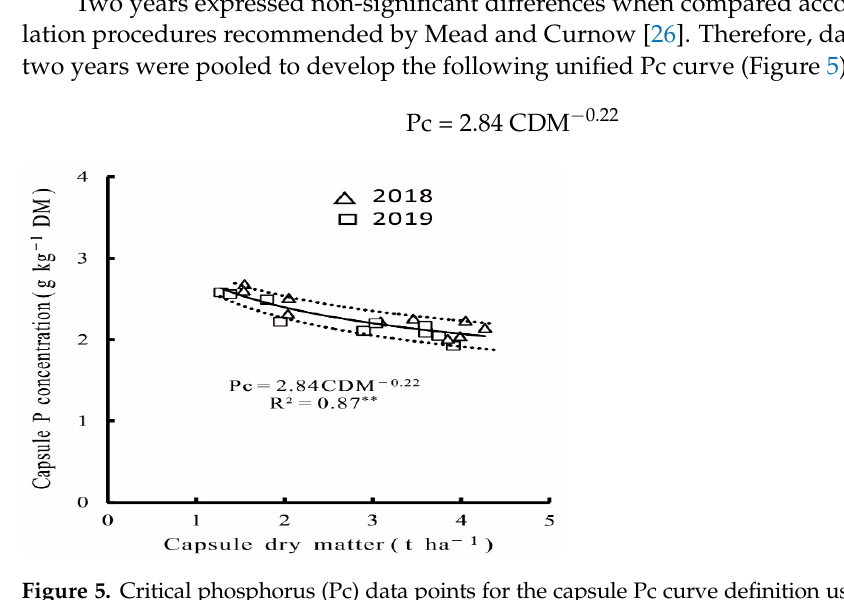
Figure 4. Critical phosphorus (Pc) data points were used to define the critical P dilution curve. The solid line represents the critical P dilution curve, depicting the relationship between the critical P concentration and the capsule dry matter of flax in Gansu, northwest China. The dotted lines represent the confidence intervals ( p = 0.95). ** Significance at p < 0.01 probability level.